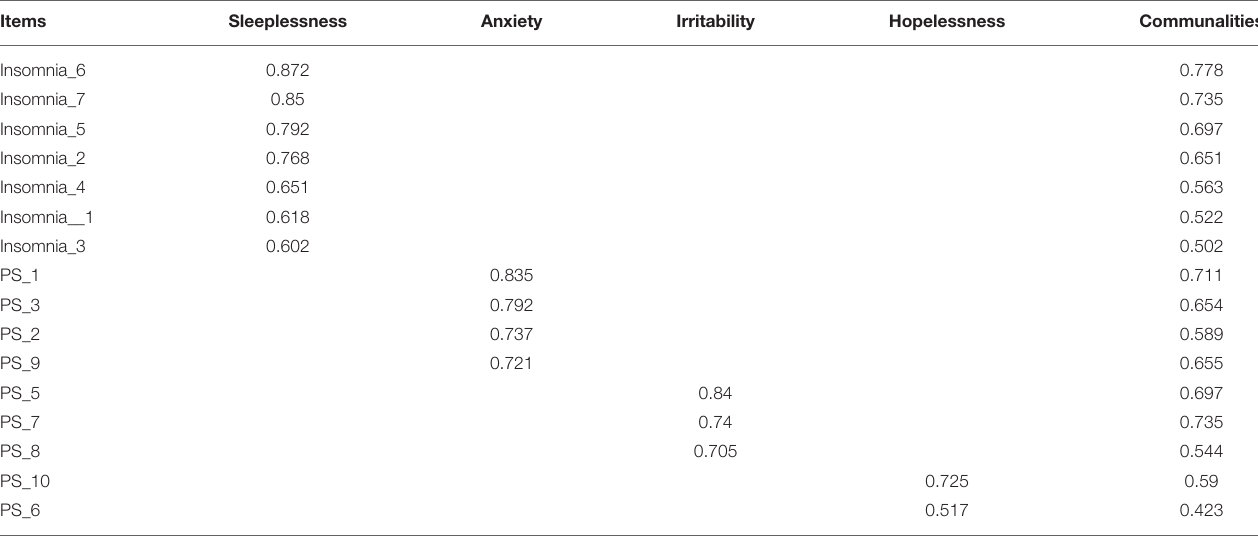
TABLE 3 | Rotated component